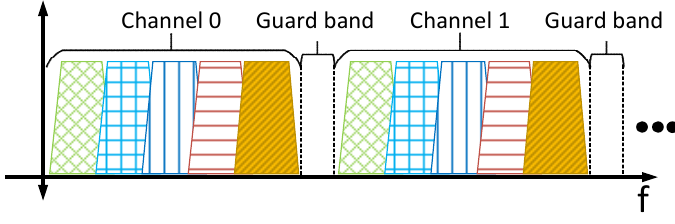
Figure 2. Frequency domain of OFDM system.